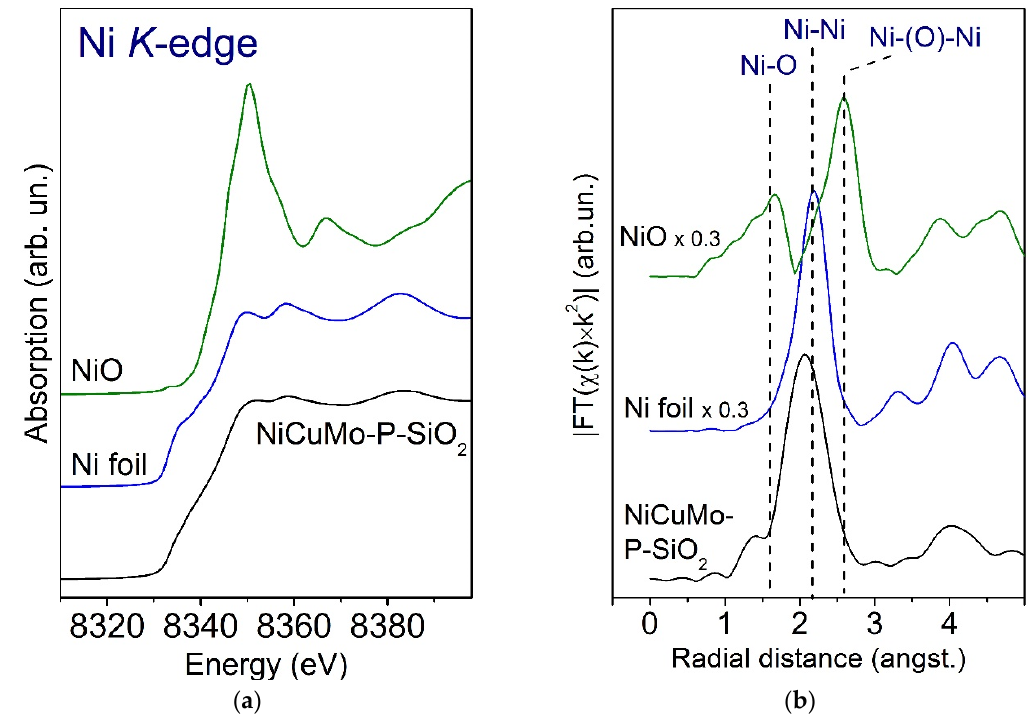
Figure 5. ( a ) Ni K-edge XANES spectra; ( b ) The module of k 2 -weighted Fourier transforms of k 2 χ (R) EXAFS-oscillations at the Ni K-edge for NiCuMo-P-SiO 2 catalyst after additional in situ reduction at 400 ◦ C, in comparison to Ni foil and NiO